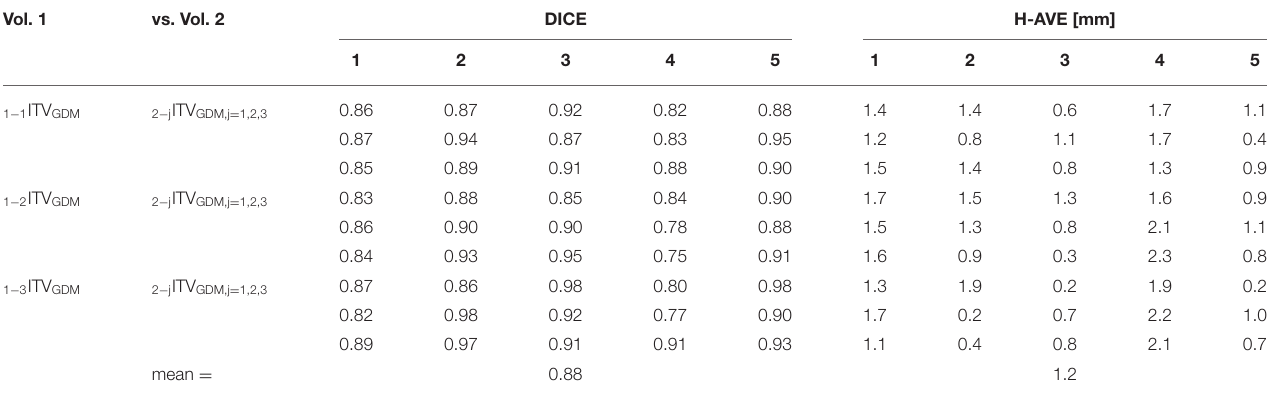
TABLE 2 | Inter-observer variability results (DICE and H-AVE) of mutual comparisons of ITV GDM volumes after triple image registration made by 2 observers (3 tests for each of 5 patients). Vol. 1 vs. Vol. 2 DICE H-AVE [mm]